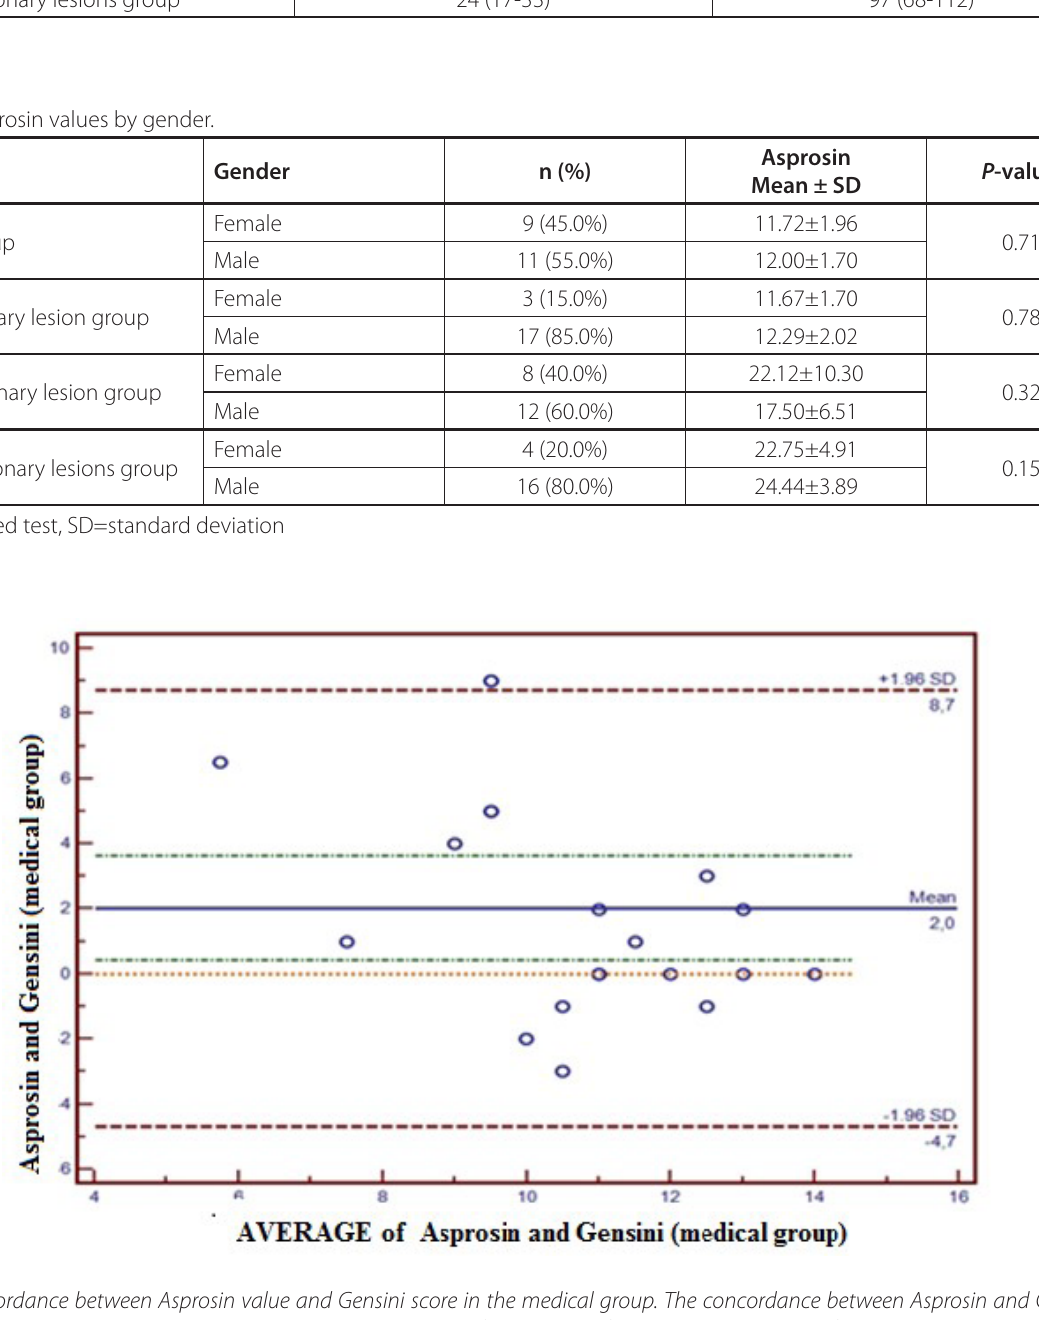
Fig. 2 - Concordance between Asprosin value and Gensini score in the medical group. The concordance between Asprosin and Gensini by Bland-Altman method in the medical group was -4.7 to 8.7 at a confidence level of 95%. Five percent (5%) of total observations was observed out of confidence level of 95%. SD=standard